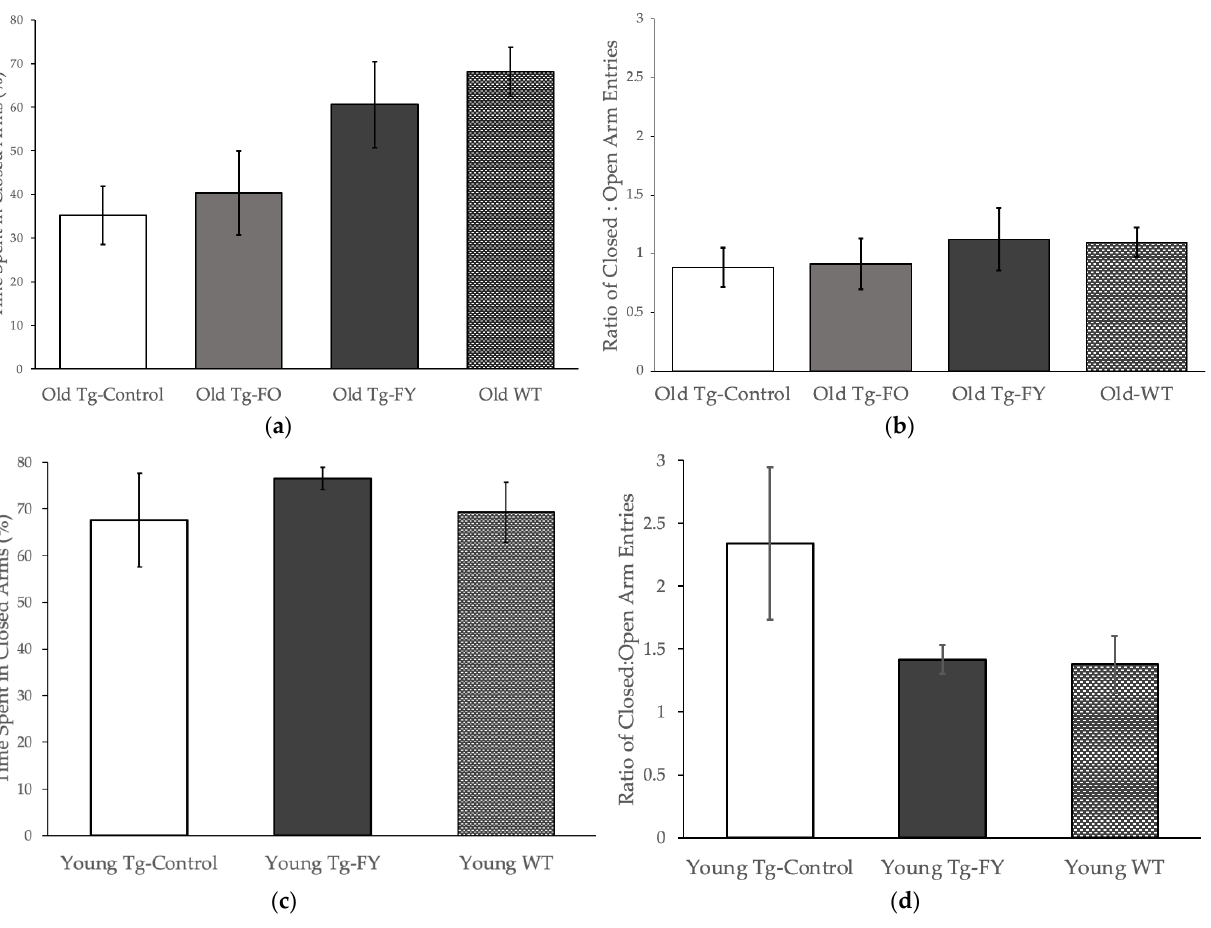
Figure 2. FMT treated mice show normalization of behavior approaching control levels on the elevated plus maze. Old Tg-FY groups ( n = 8) show improvement in anxiety-related behavior with increased ( a ) Percentage of time spent in closed arms and ( b ) Ratio of Closed:Open arm entries. Young Tg-FY group ( n = 8) showed overall decreased anxiety with ( c ) a small increase in Percentage of time spent in closed arms and ( d ) decreased Ratio of Closed:Open arm entries. Data is presented as mean ± SEM. Young Tg-FY: Young Transgenic-Fed Young, Young Tg-Control: Young Transgenic Control, Old Tg-FY: Old Transgenic-Fed Young, Old Tg-FO: Old Transgenic-Fed Old, Old Tg-Control: Old Transgenic Control, Young WT: Young Wildtype, Old WT: Old Wildtype